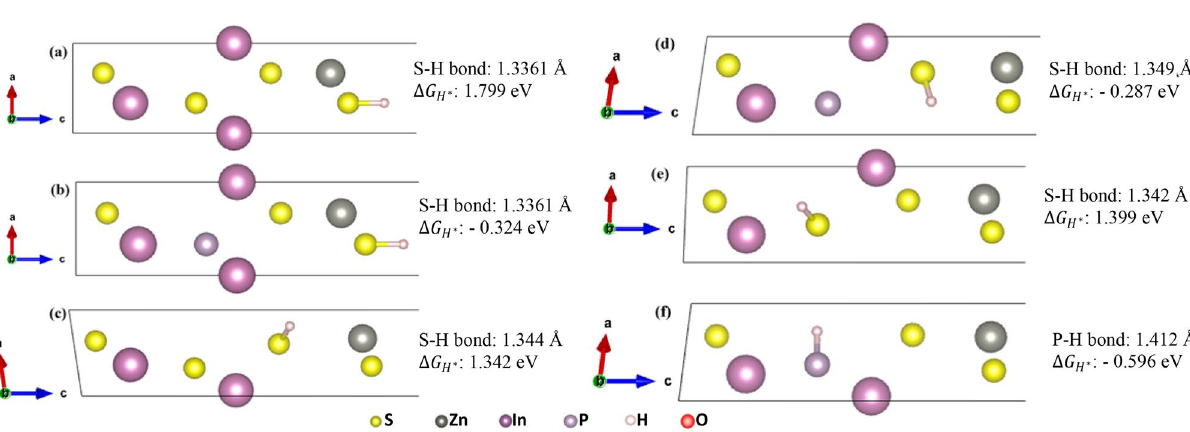
Figure 6. Relaxed monolayer structures, (cid:31) G H ∗ and hydrogen interactive bond length for ( a ) ZIS (H* on